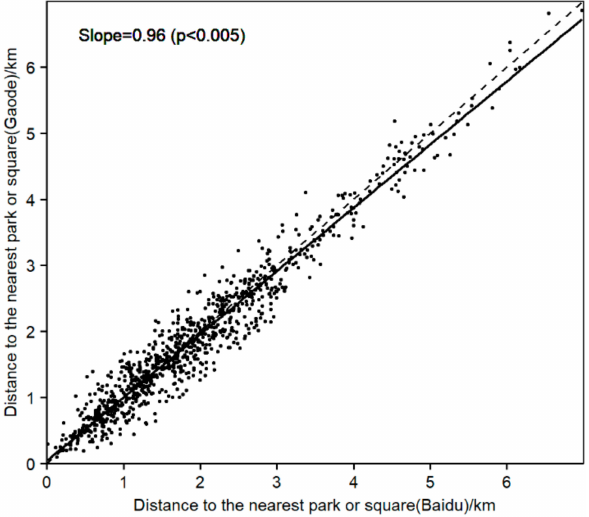
Figure 3. Comparison of the walking distance to the nearest park from Baidu Map API and Gaode Map